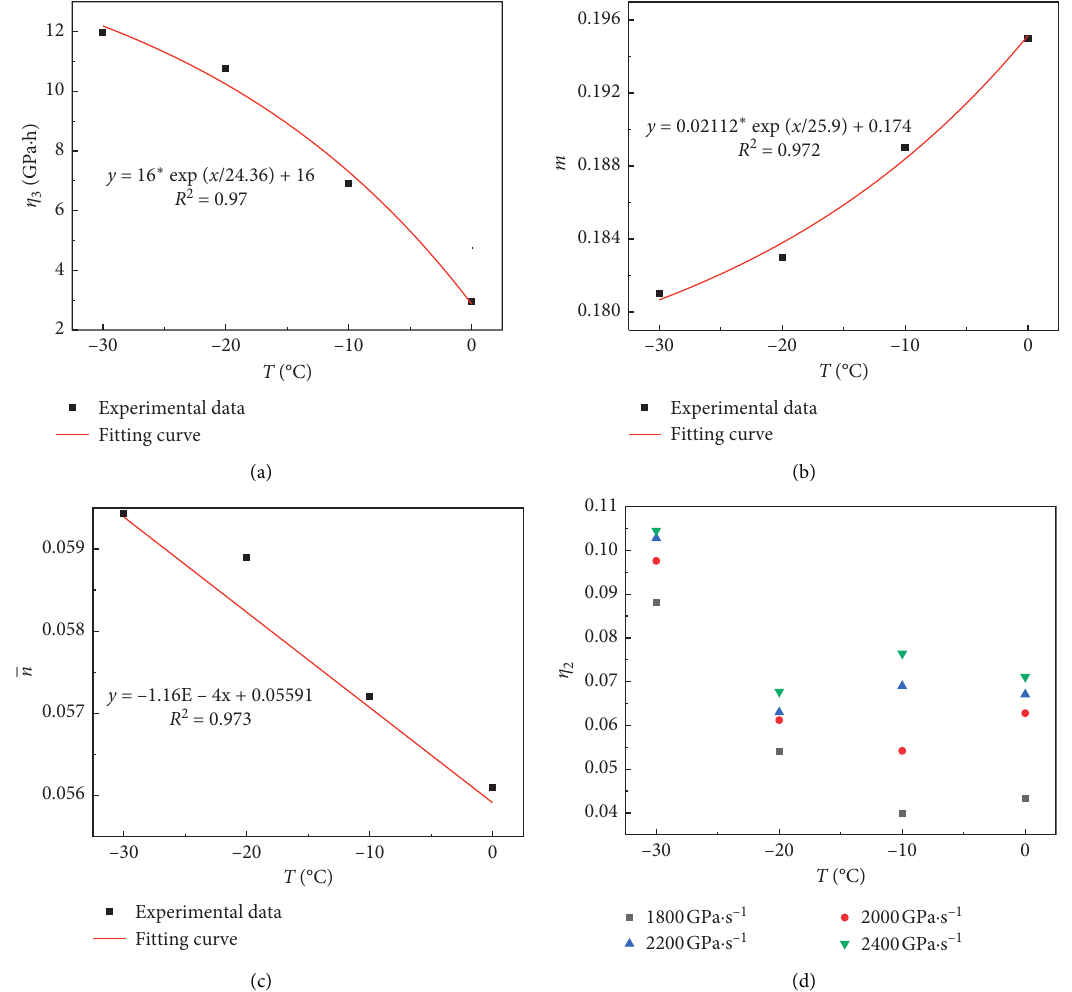
. (b) m . (c) n . (d) η . 3 2